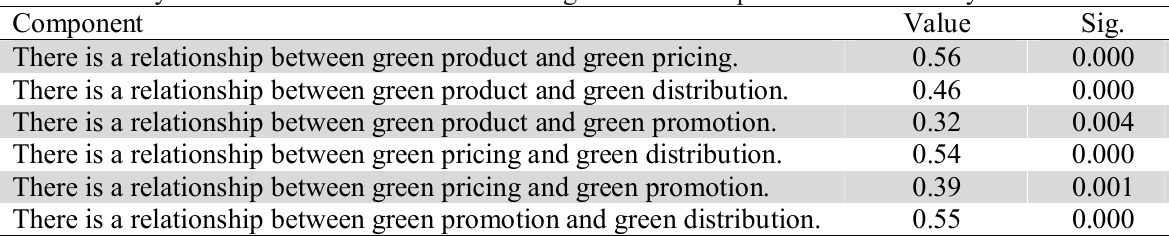
Value Sig. 0.56 0.000 0.46 0.32